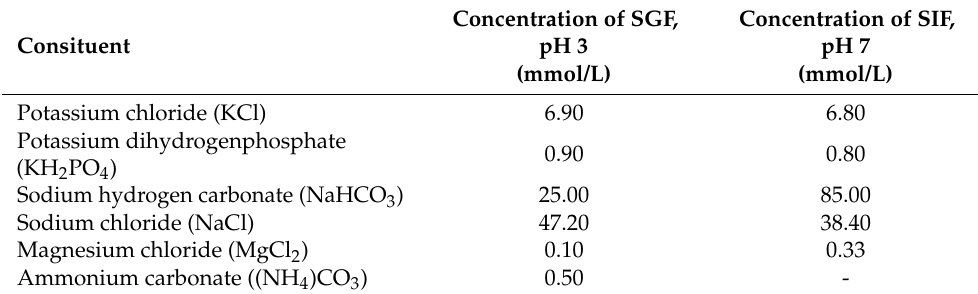
Concentration of